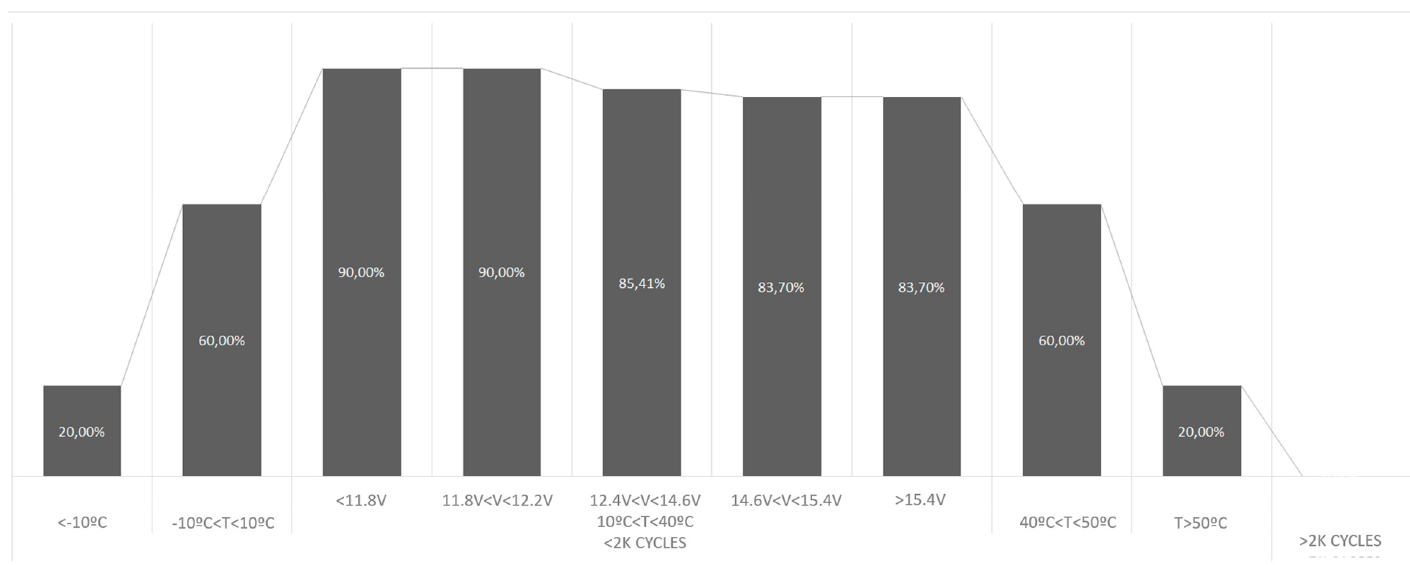
Figure 6. Maximum probability values obtained by the Bayesian network for the CARISMA